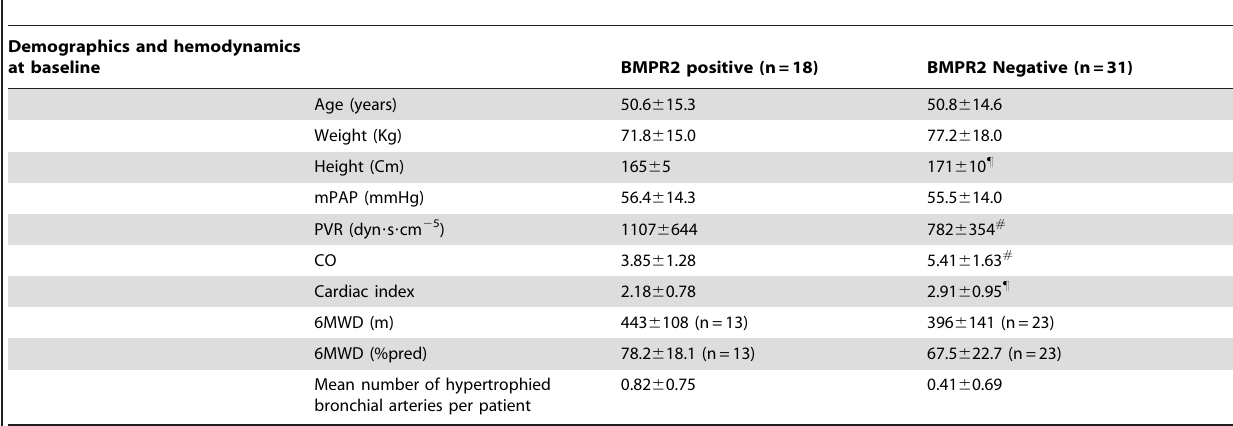
Table 4. Baseline demographics, hemodynamics and bronchial artery hypertrophy characteristics of the BMPR2 sub population